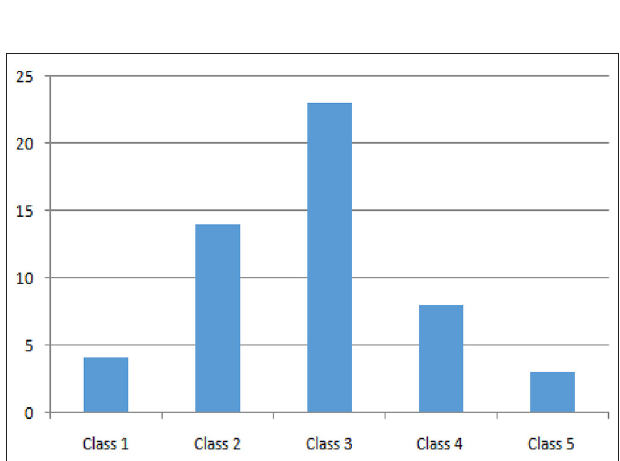
FIGURE 5 | Distribution of patients by income group, from the poorest (Class 1) to the richest (Class 5).